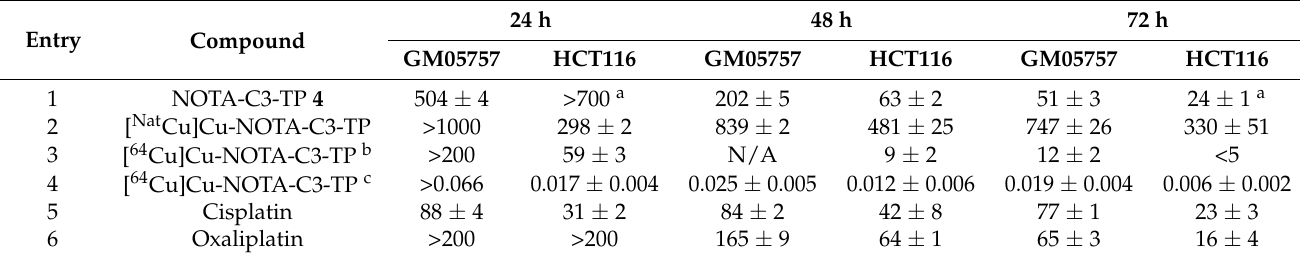
Table 1. EC 50 values ( µ M) of Pt(II) derivatives for both colorectal cancer (HCT116) and normal fibroblast (GM05757)